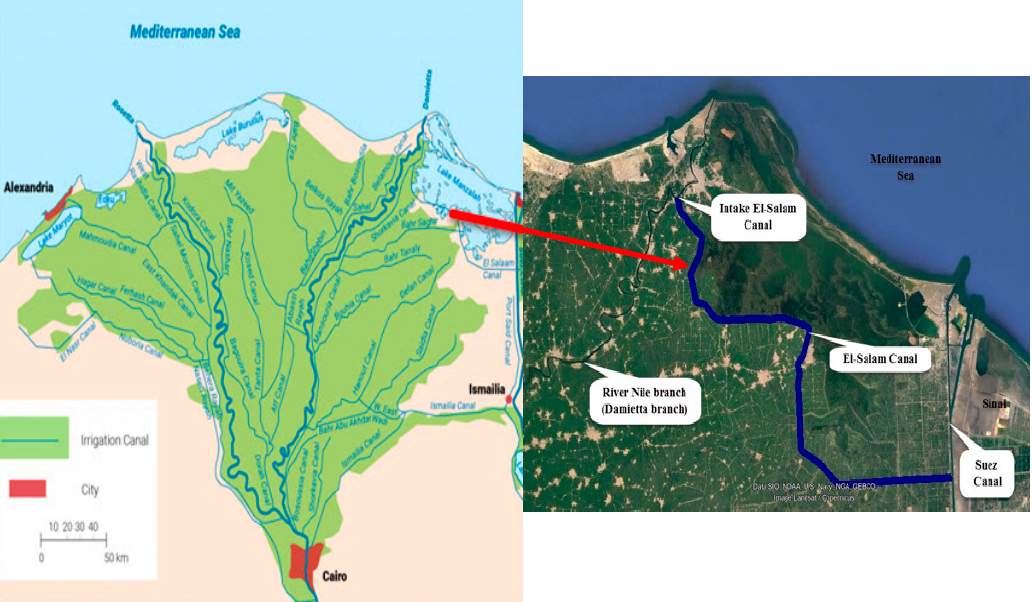
Figure 1. Location map of irrigation canals in the Nile Delta and El-Salam Canal path (Google Earth) (MWRI, 2005) [30] .